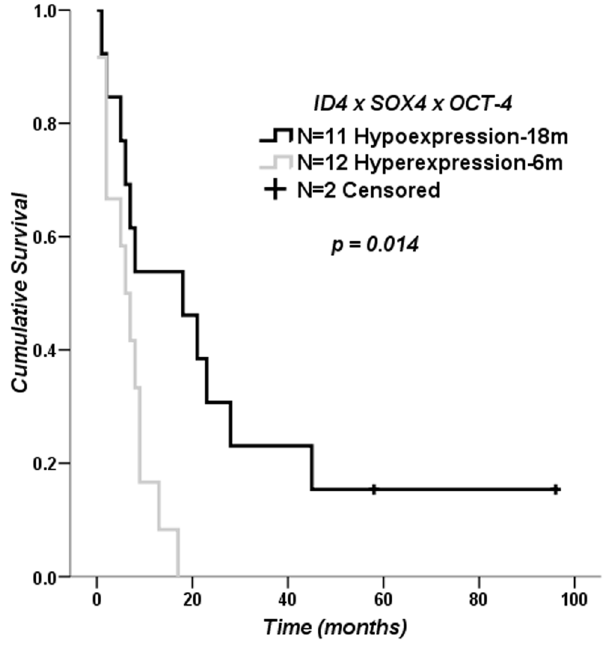
Figure 6. Survival curve of GBM patients. Twenty-five GBM cases out of 86 GBM cases presented concomitant high or low ID4 , SOX4 and OCT-4 relative expresssion levels (12 GBM cases presenting high expressions and 13 low expressions for the three genes). The survival time difference between the two groups was statistically significant ( log rank p -value=0.014), presenting median survival time of 6 months for GBM cases presenting concomitant high expressions for the three genes compared to 18 months for GBM cases with low